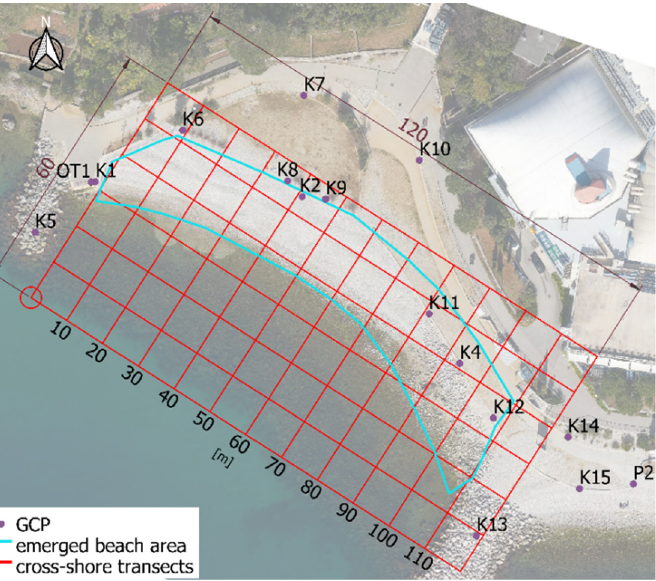
Figure 5. Location of cross-shore transects marked 10-110; blue polygon shows the extent of the area for beach area and volume calculations.